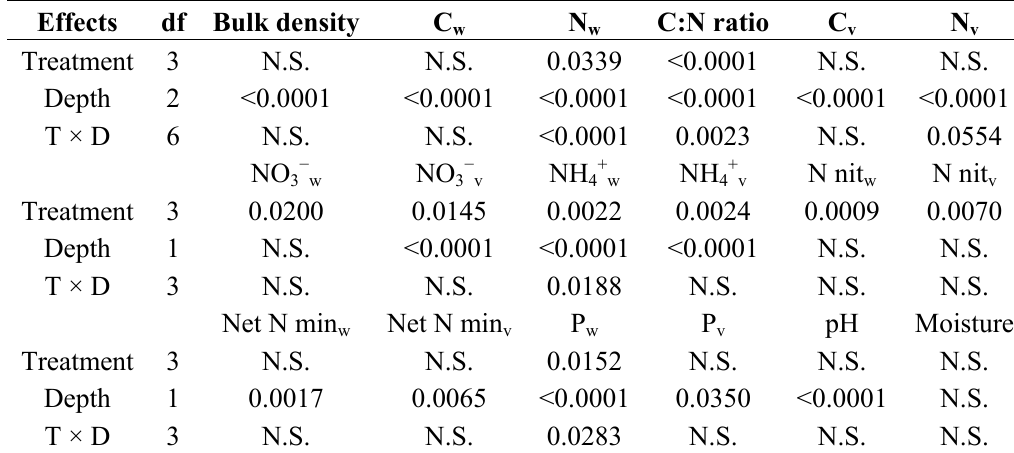
Table 3. Results of a GLMM testing the effect of treatment, depth and interaction treatment × depth on soil pH, soil bulk density, Mehlich P, and soil C and N pools and mineralization rates for the 2009 post-treatment. p -values and degrees of freedom were produced with Wald χ 2 tests. The reference treatment was not included in the GLMM testing. N.S. = not significant; W = weight; V =